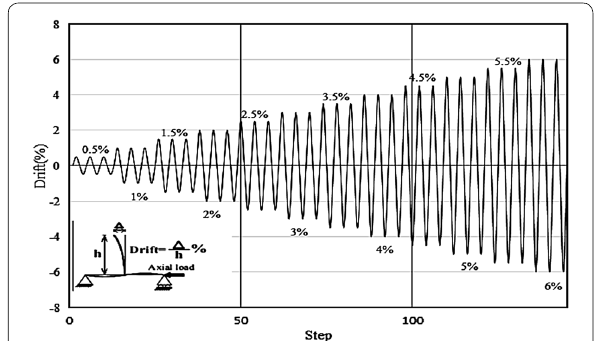
Fig. 14 Loading protocol.